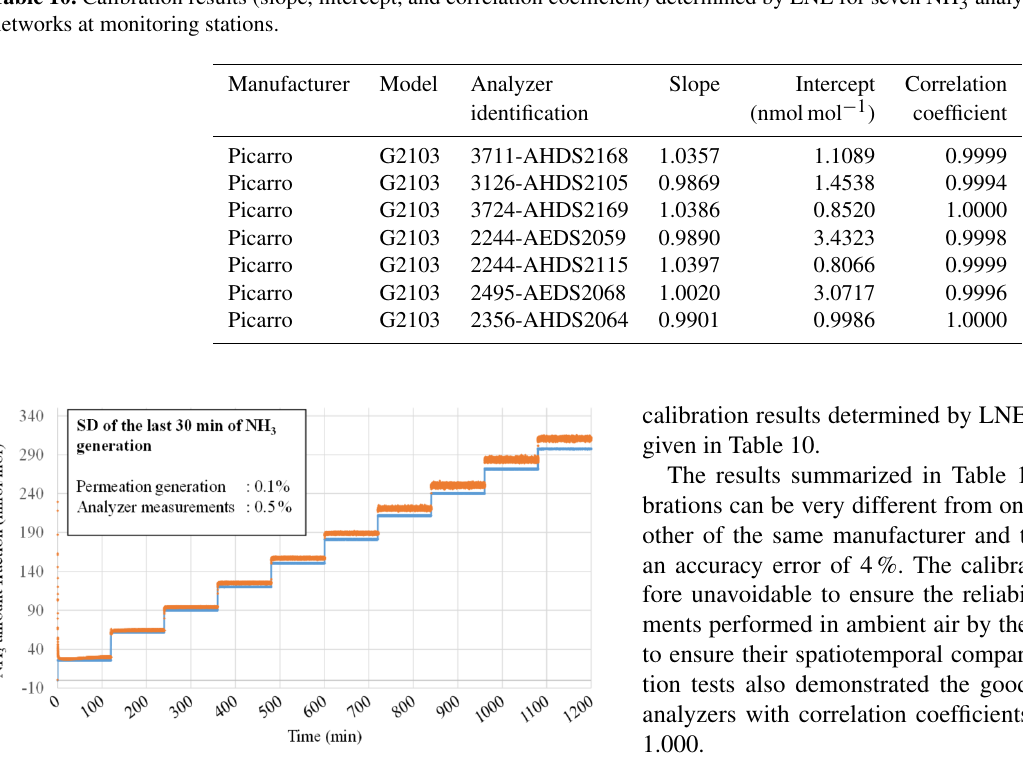
Figure 6. Stability of the ammonia reference amount-of-substance fractions (blue line) and of the analyzer readings (orange color) over the range from 1 to 300nmolmol − 1 . The relative standard deviation of the analyzer readings is lower than 0.5% for all the generated amount-of-substance fraction levels.